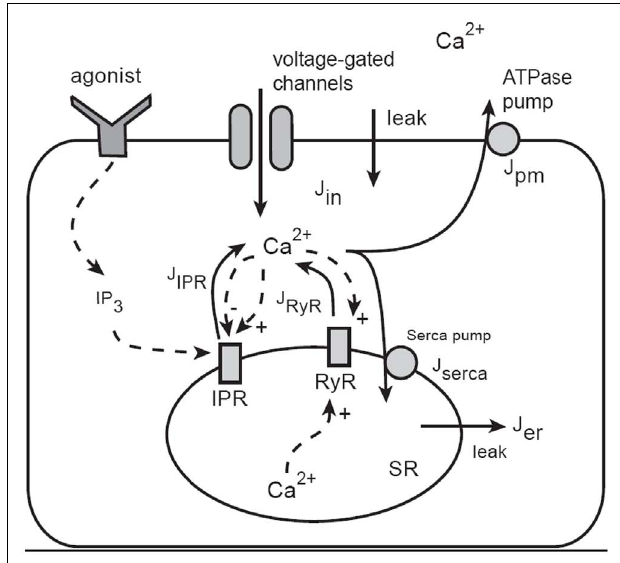
FIGURE 7 | Schematic diagram of the Ca 2 + model. Calcium can enter the cytosol through IP 3 receptors (IPR), ryanodine receptors (RyR), or generic voltage-gated channels and leaks. Ca 2 + is removed from the cytoplasm by ATPase pumps on the membrane of the SR and on the plasma cell membrane. IPR are activated by IP 3 , which is produced as an end-product of agonist stimulation of cell-surface receptors. Calcium in the cytosol can diffuse, and is heavily buffered.The buffers are not shown explicitly as they are incorporated via an effective diffusion coefficient and effective reaction